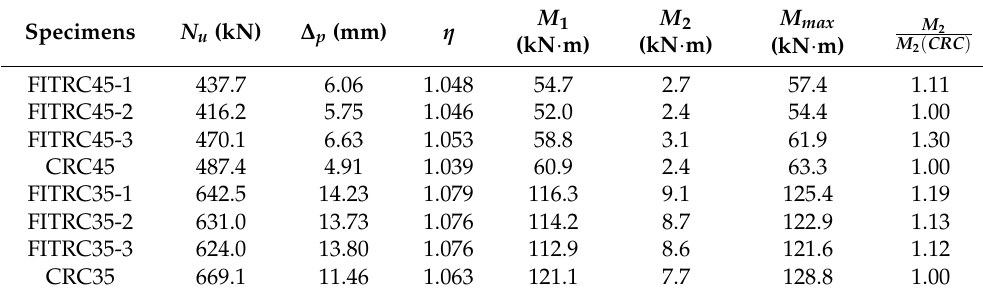
Table 10. Moments of RC